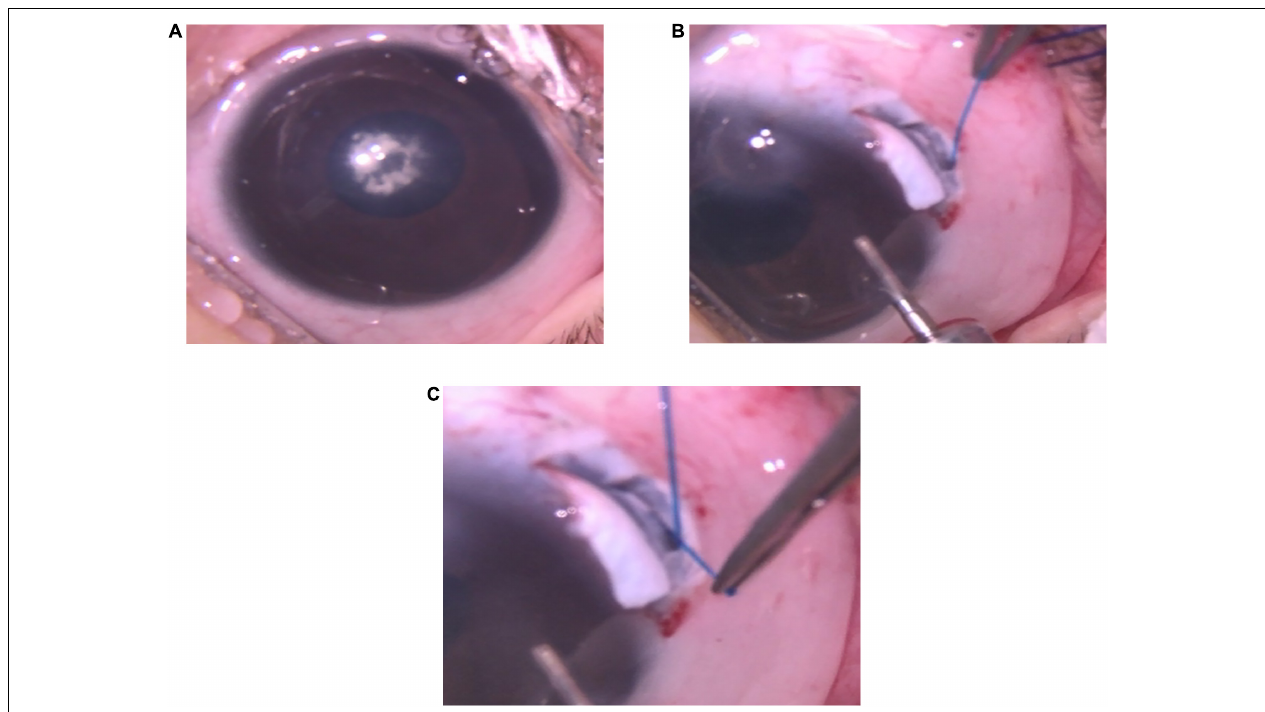
FIGURE 2 | Operative photos of the left eye. (A) The cornea was cloudy and nuclear cataract occluded the visual axis. (B) The tip of a 5-0 suture was inserted into Schlemm’s canal and threaded circumferentially in Schlemm’s canal during trabeculotomy. (C) The tip of the 5-0 suture appeared in the opposite ostium of Schlemm’s canal.